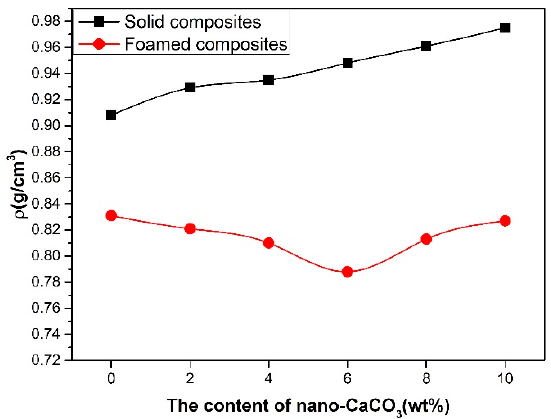
Figure 13. The density of solid composites and foamed composites.